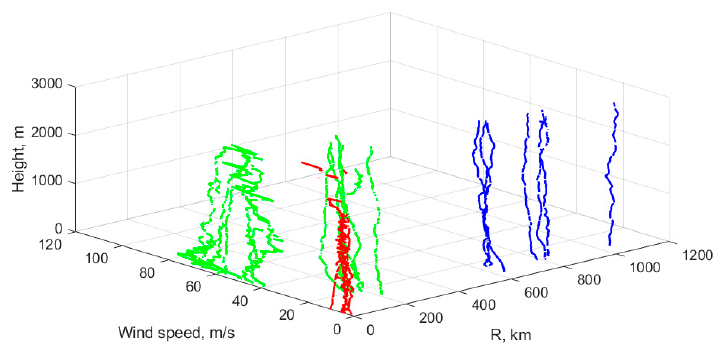
Figure 1. 3-D illustrations, the axes respectively show the distance from the center of the hurricane (obtained by comparing the measurement data of the coordinates of the NOAA GPS-dropsondes and the coordinates of the hurricane’s track at the time the GPS-dropsonde fell), with the wind speed and altitude measured by the GPS sensor of the falling GPS-dropsonde. Dataset for hurricane Dean, 2007/08/19. Red profiles correspond to the eye of the tropical cyclone (excluded from the analysis); blue profiles indicate the data obtained far from the tropical cyclone center (wind speeds less than 20 m/s, excluded from the analysis); green profiles represent the data used for the statistical analysis. As a result, wind speed profiles averaged over the profile groups could be obtained (see Figure 2a).